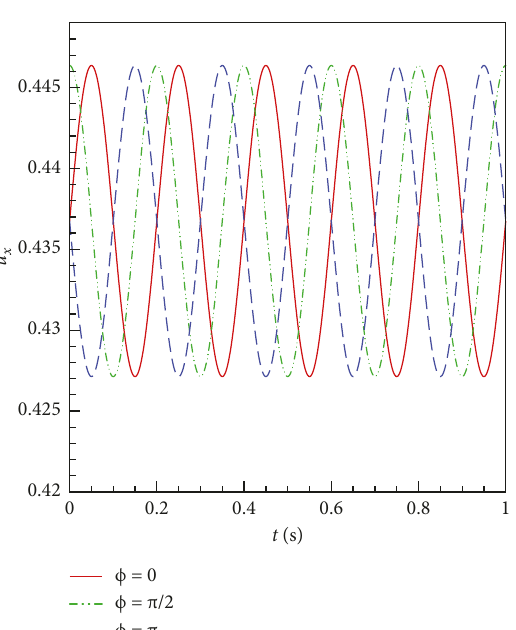
Table 4: Mixing efficiency at t � 1s in the three geometries at u � 0.1 mms − 1 and f � 5Hz. Phase difference (Rad) Circular